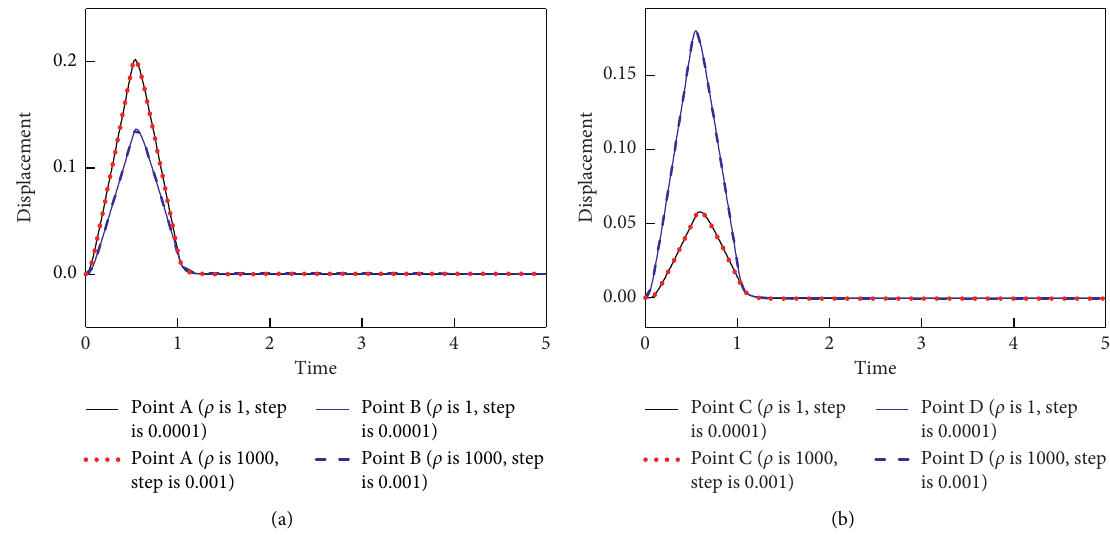
Figure 10: Comparison of the Y -direction displacement at the observation points after adjusting the density of the artificial boundary elements and the calculating step size: (a) points A and B, (b) points C and